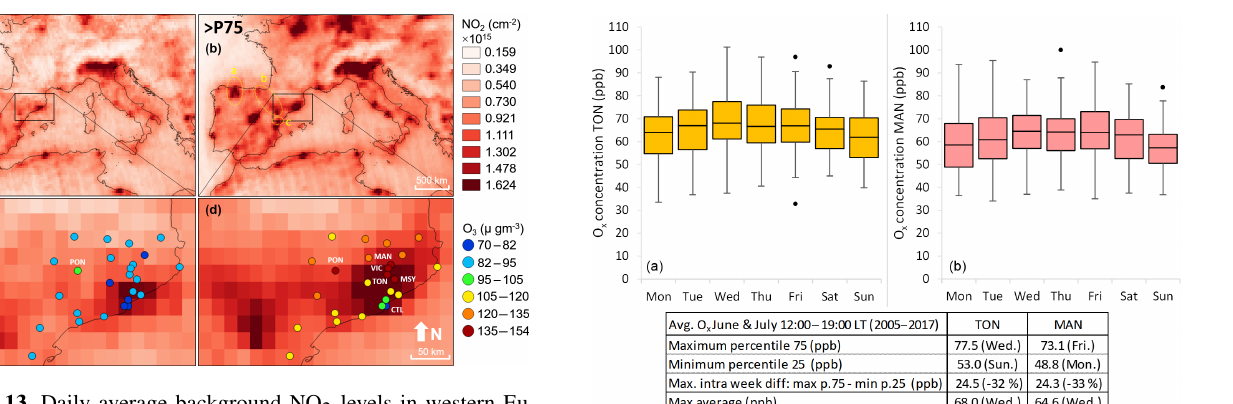
Figure 13. Daily average background NO 2 levels in western Eu- rope (a, b) and Catalonia (c, d) , July 2005–2017, in two dif- ferent scenarios. (a, c) P25: days when the maximum daily 8h mean O 3 concentrations in the Vic Plain are below percentile 25 ( < 105µgm − 3 ) and (b, d) P75: same but with concentrations above percentile 75 ( > 139.5µgm − 3 ).